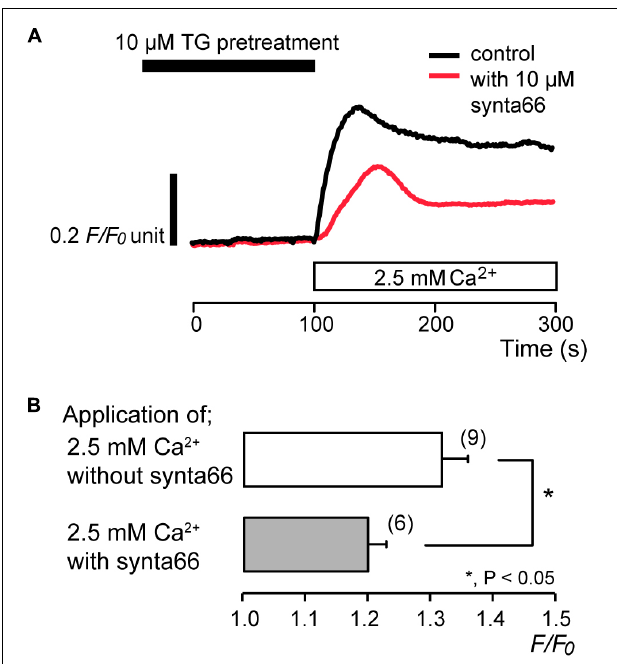
FIGURE 3 | Synta66 inhibits SOCE. (A) Representative traces of SOCE in response to subsequent application of 2.5 mM extracellular Ca 2 + (white box at bottom) after pre-incubation with 10 µ M TG (black box at the top) with (red line), or without (black line) 10 µ M synta66. (B) Summary bar graph shows [Ca 2 + ] i increases by addition of extracellular Ca 2 + without (open column) or with 10 µ M synta66 (gray column). Each column indicates the mean ± SE of 6–9 independent experiments. Statistically significant differences between columns (shown by solid lines) are denoted by asterisks, ∗ P < 0.05.